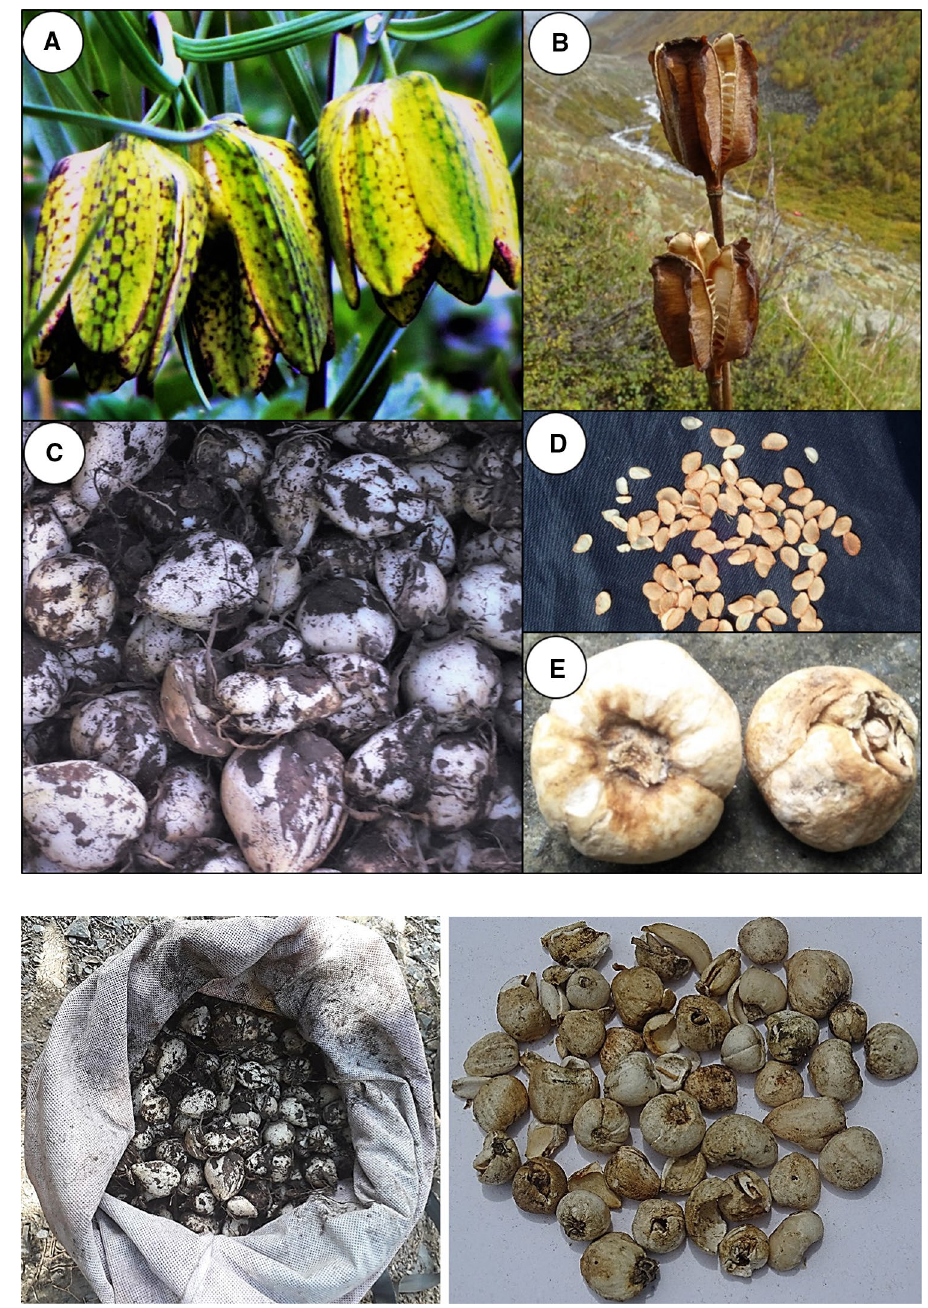
Fig. 2 Fritillaria cirrhosa D.Don. A Flower, B follicle, C immature bulb, D seed, E mature bulb